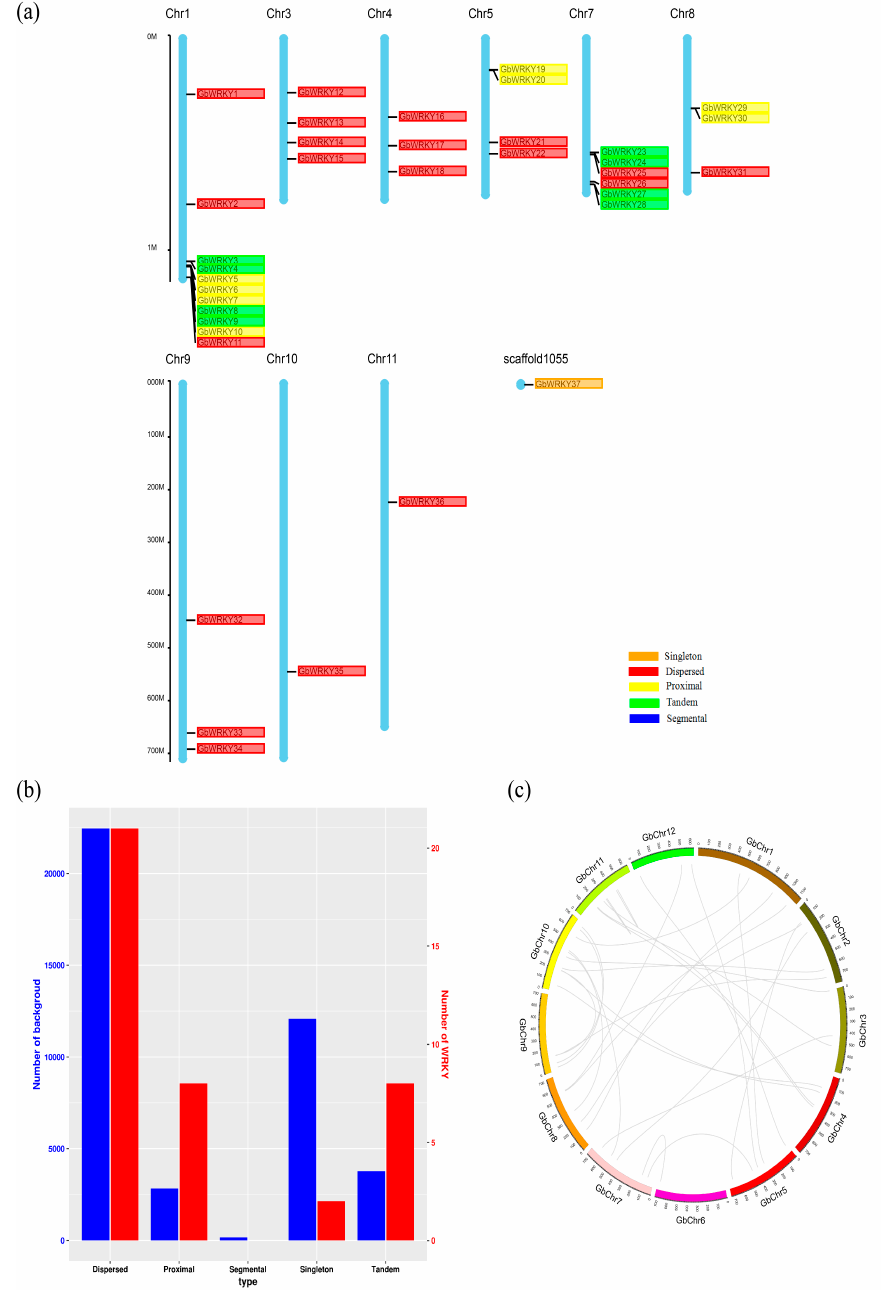
Figure 1. Chromosomal distribution and gene duplication of GbWRKYs genes. ( a ) Chromosomal distribution and gene duplication analysis of GbWRKYs, they were performed by Circos software and MCScanX, respectively; ( b ) statistical map of the number of replicating genes of each type; ( c ) collinearity analysis. The proximal duplicated genes are indicated in yellow. Tandem duplications are indicated in green.